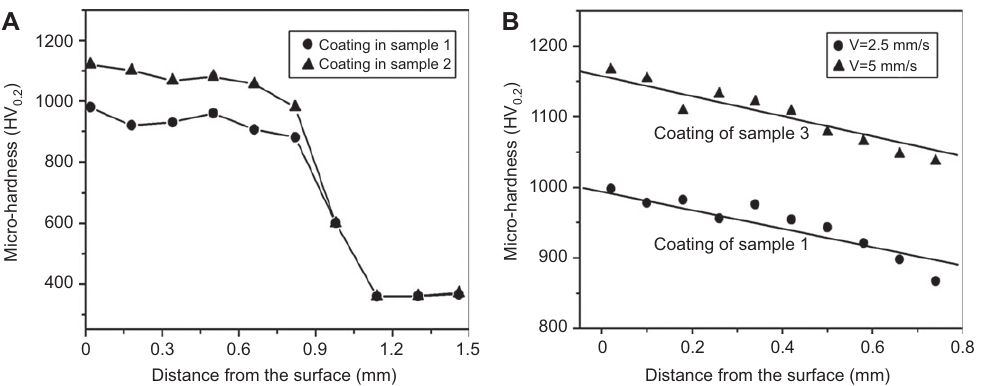
Figure 6 Micro-hardness distributions of the alloying coating in different samples. (A) Coatings in samples 1 and 2, and (B) coatings with the different scanning